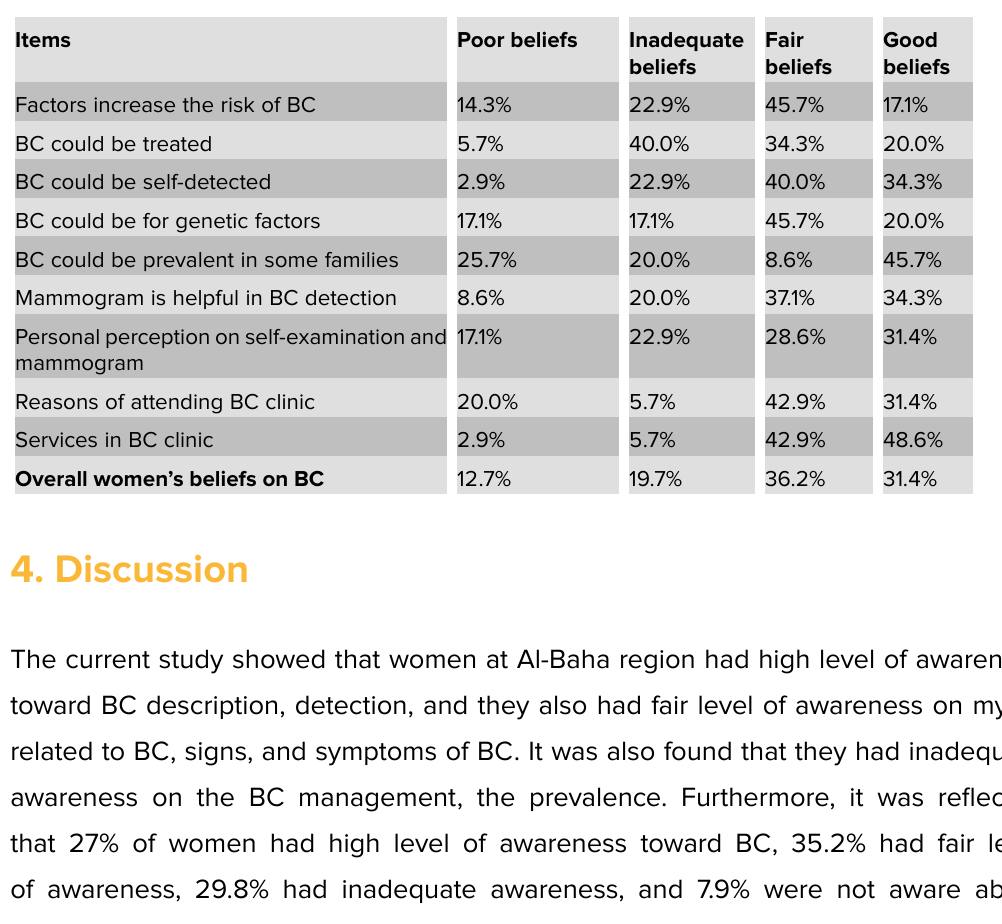
Figure 1 : Overall women’s awareness on breast cancer at Al-Baha region. Table 3: Women’s beliefs on breast cancer at Al-Baha region, n =